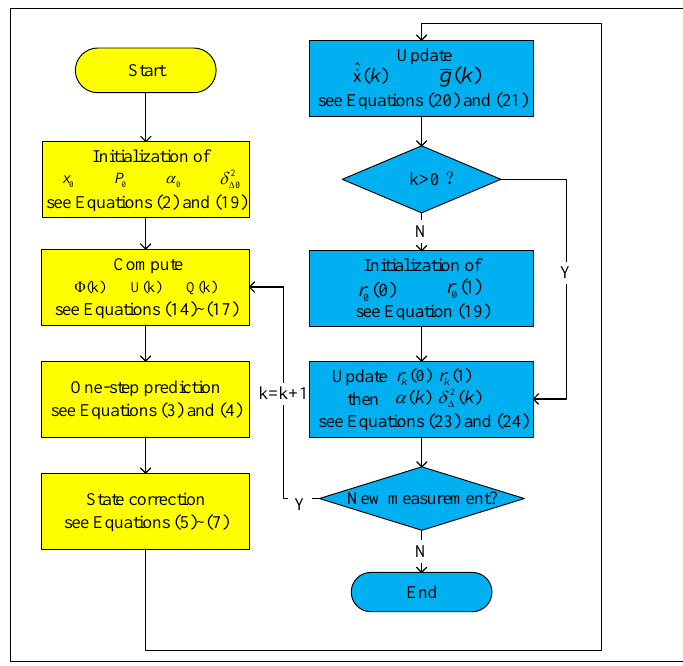
Figure 1. The flow chart of the proposed online denoising